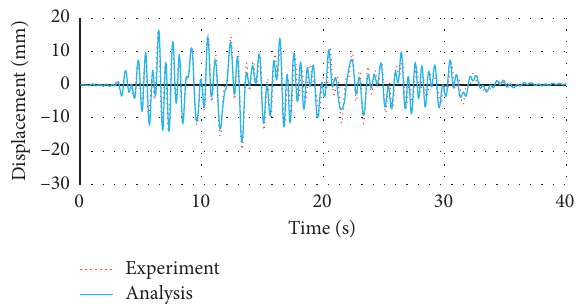
Figure 6: History lateral displacements of the second storey ob- tained from analysis and experiment [20,